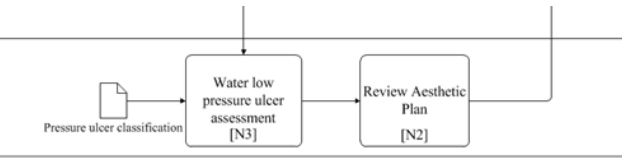
Figure 3. Extension of clinical pathway for major gynaecology surgery with